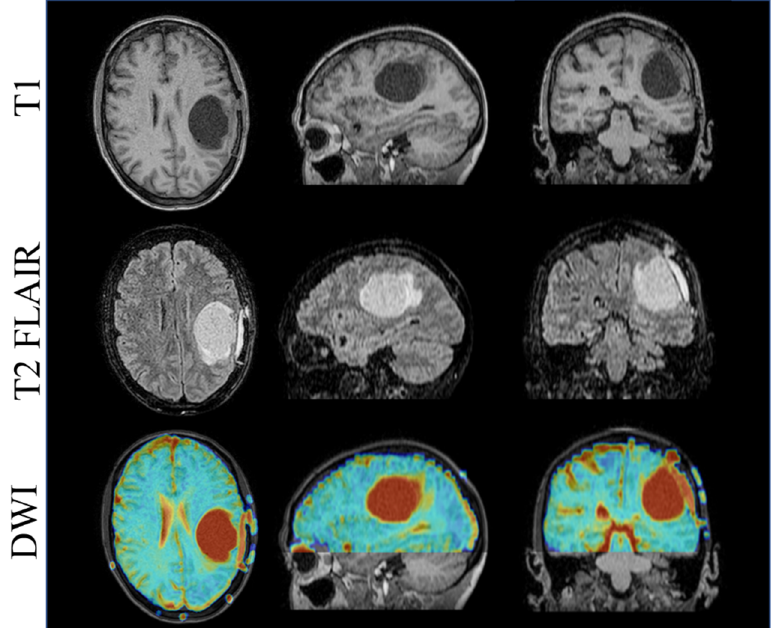
Figure 8. T1 ( Top ), T2 FLAIR ( Center ), and DWI ( Bottom )-imaging 1.5T MR-linac.